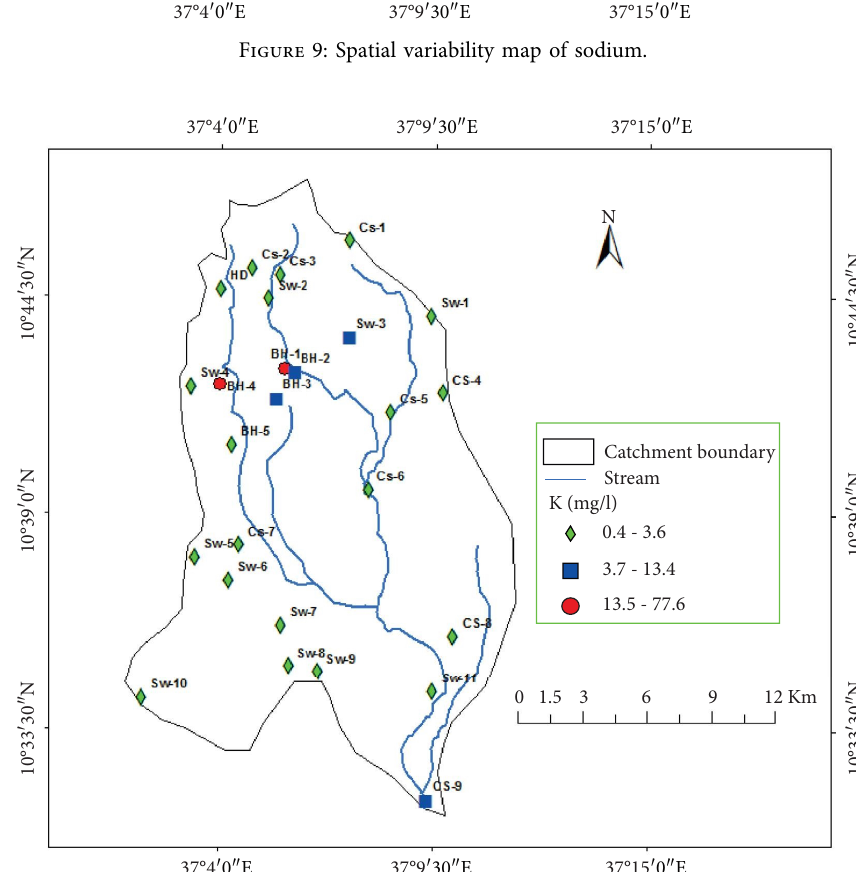
Figure 10: Spatial variability map of